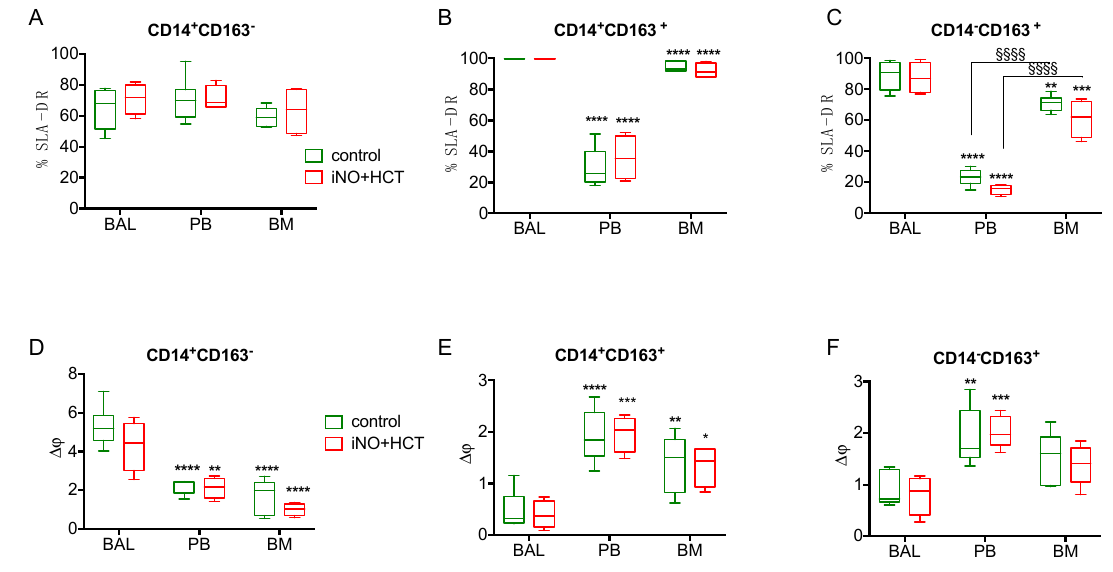
Figure 4. Compartment-specific changes in the activation status of monocytes following 20 h of endotoxemic shock. The expression of SLA-DR antigen was evaluated 20 h after the onset of endotoxemic shock in cells from the bronchoalveolar lavage fluid (BAL), peripheral blood (PB), and bone marrow (BM). The SLA-DR antigen was analyzed in: ( A ) CD14 + CD163 − monocytes, ( B ) CD14 + CD163 + monocytes, and ( C ) CD14 − CD163 + monocytes. The mitochondria membrane potential ( Δ 𝜑 ) was also analyzed in these three compartments in: ( D ) CD14 + CD163 − monocytes, ( E ) CD14 + CD163 + monocytes, and ( F ) CD14 − CD163 + monocytes. Mean values ± SD are presented. n = 6/group. The statistical significance of differences between values for BAL vs. PB or BM in each experimental group: * p < 0.05, ** p < 0.01, *** p < 0.001, **** p < 0.0001. Significant differences between PB and BM §§§§ p < 0.0001. No differences were noted between control and treated group. 4. Discussion We utilized a porcine model of prolonged resuscitated endotoxemic shock to inves- tigate the effects of inhaled nitric oxide (iNO) and hydrocortisone (HCT) treatment on monocyte functions. Our study showed that the combined treatment has little effect on